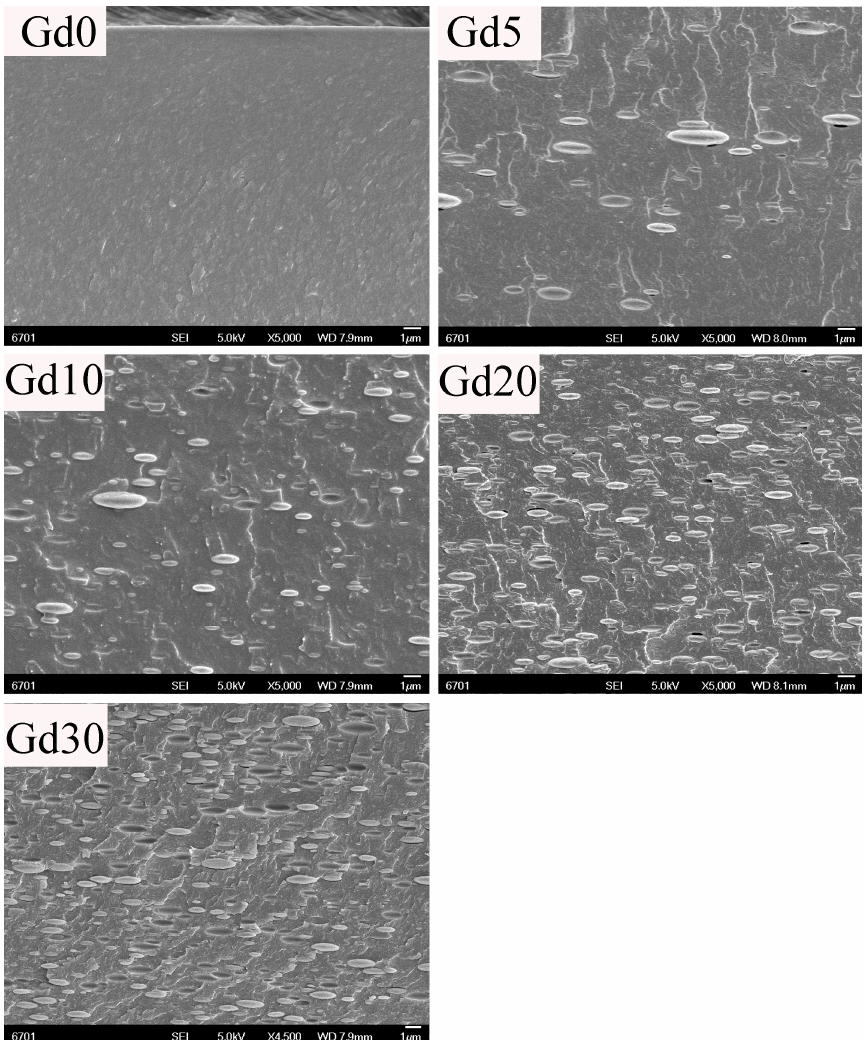
Figure 2. SEM micrographs of of CS/GPs composites with various amounts of added GPs.